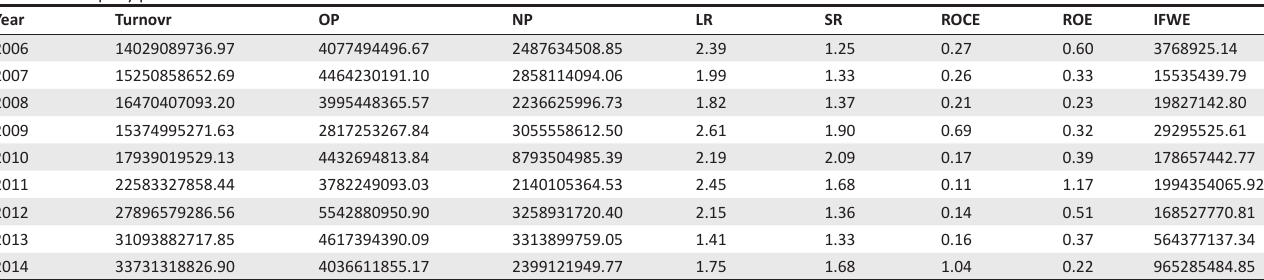
TABLE 6: Company performance measures standard